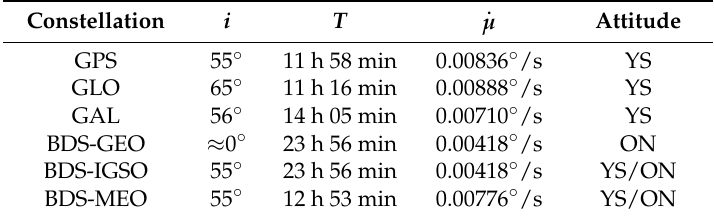
Table 1. GNSS orbits and attitude mode ( i : orbital inclination, T : orbital period, angular velocity, YS: yaw-steering, ON: orbit normal).